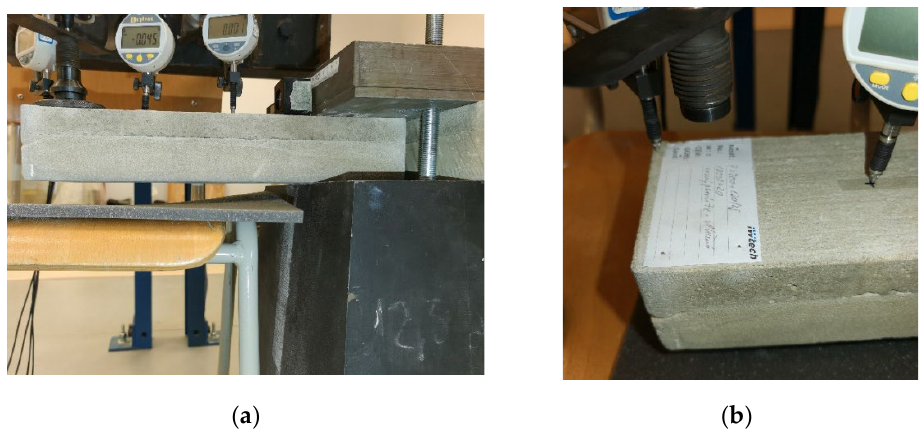
Figure 4. Detail of ( a ) experimental measuring setup; ( b ) and labeling of